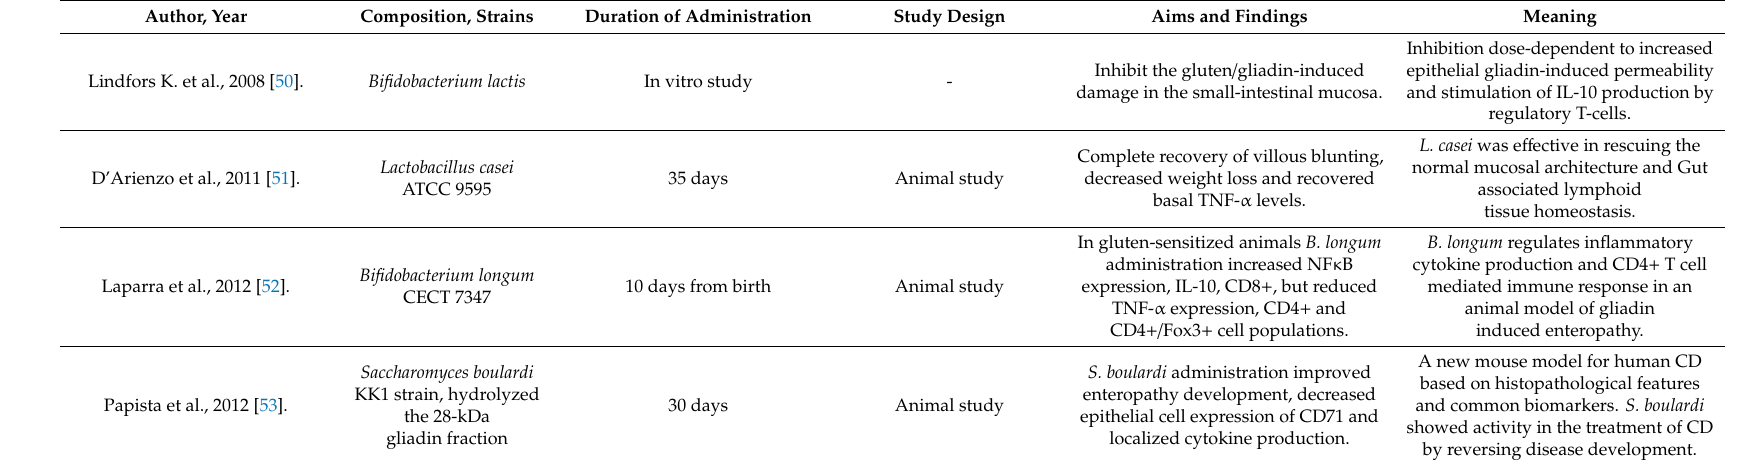
Table 1. Studies evaluating probiotic use in celiac disease in vitro, ex vivo, and in animal models.